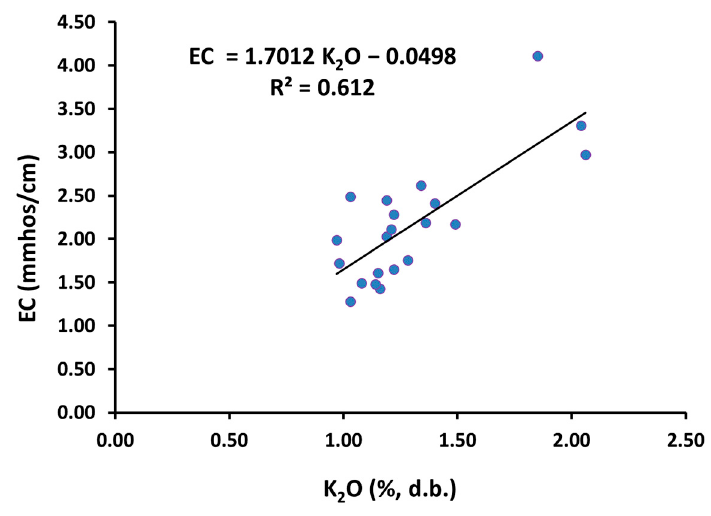
Figure 3 . Variation in electrical conductivity (EC) with respect to K 2